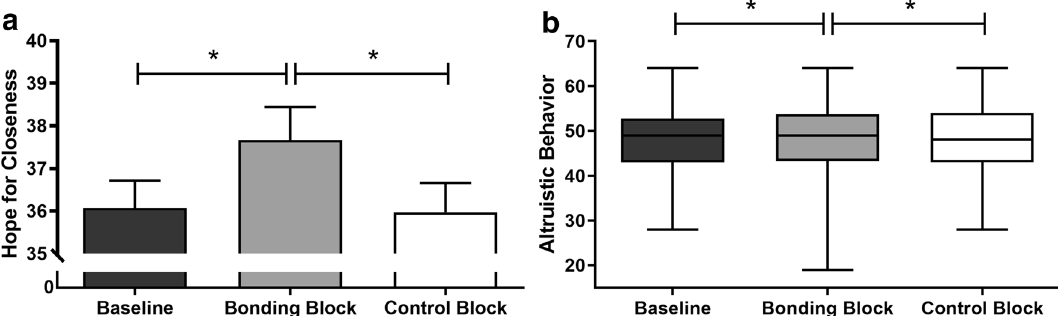
Figure 5. Mood state scores in study 1. Note ( a ) Self-reported hope for closeness assessed before (baseline) and after bonding and control blocks. Bonding pictures promoted greater hope for closeness compared to baseline and to control block levels. Error bars indicate standard error. ( b ) Altruistic behavior assessed before (baseline) and after bonding and control blocks. Bonding pictures promoted greater altruistic behavior when compared to baseline and to control block levels. Box extends from the 25th to 75th percentiles (interquartile range) and the error bars indicate minimum and maximum values. *p <